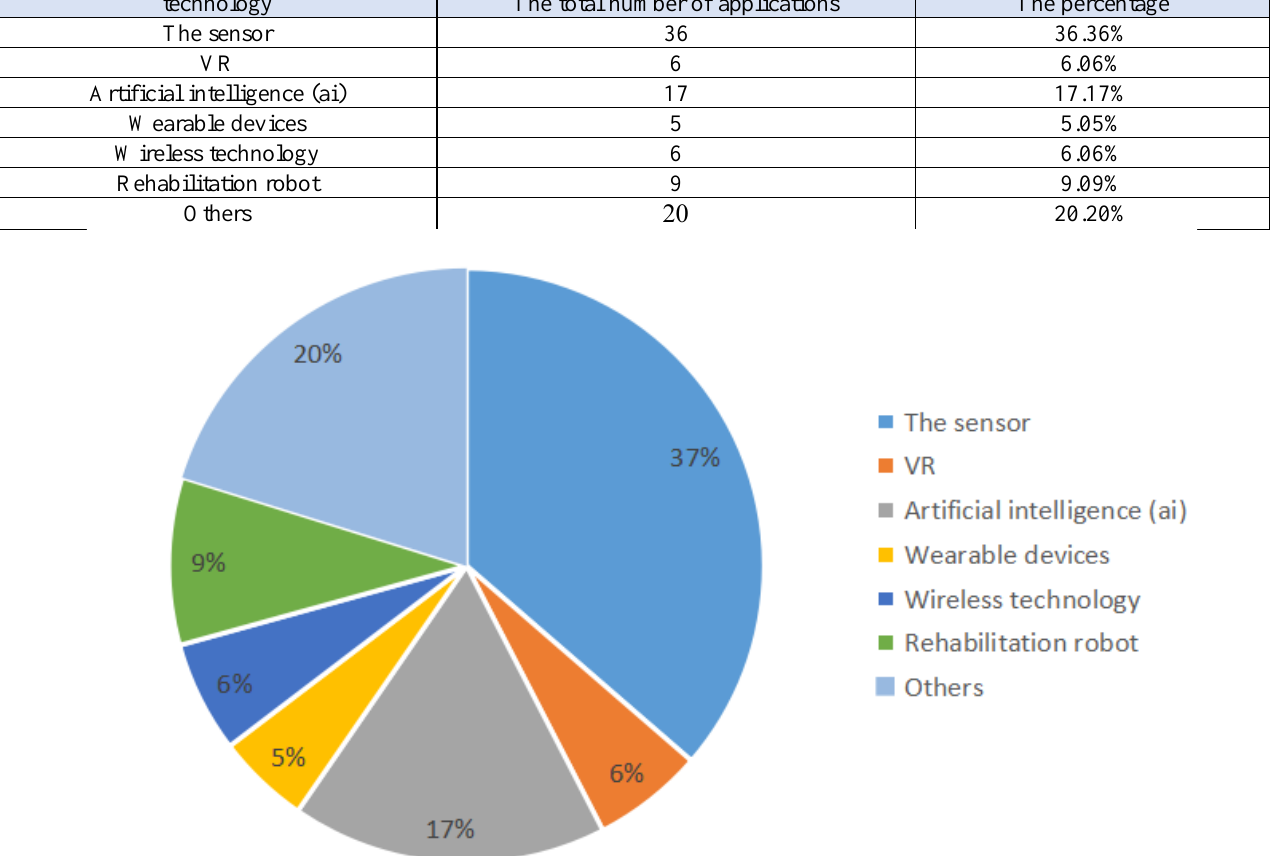
Table 2. Internet of Things technology application proportion overview chart